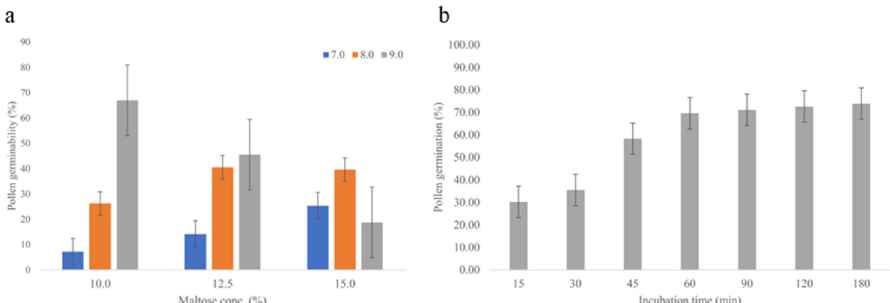
Figure 1. The germination rate of pollen ( a ) in medium with various pH values and maltose concentration combinations after 60 min incubation and ( b ) in the optimized medium under different incubation periods. Error bars indicate ± S.E.